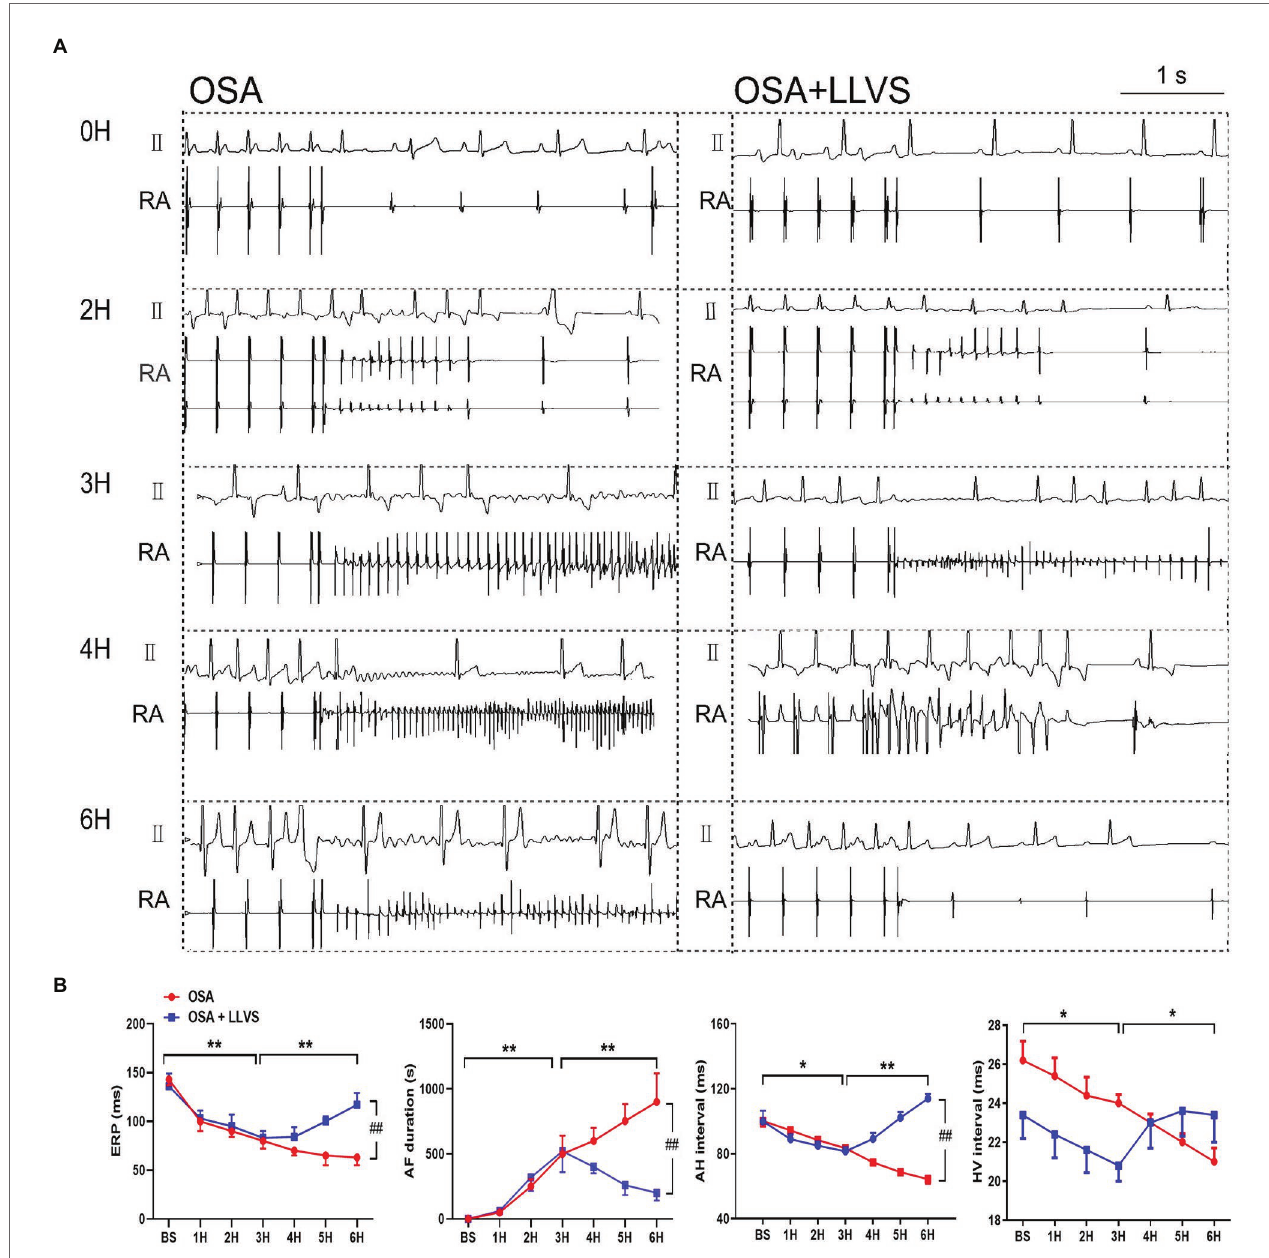
FIGURE 5 | (A) Representative examples of AF episodes in the OSA and OSA+LLVS groups at baseline, the 2nd hour, the 3rd hour, the 4th hour, and the 6th hour. (B) Changes in ERP, AF duration, AH interval, and HV interval at each hour among the three groups. * p < 0.05, ** p < 0.01, ## p < 0.05; ERP, effective refractory period; AF, atrial fibrillation; AH, Atrial-His; HV, His-Ventricle; H,